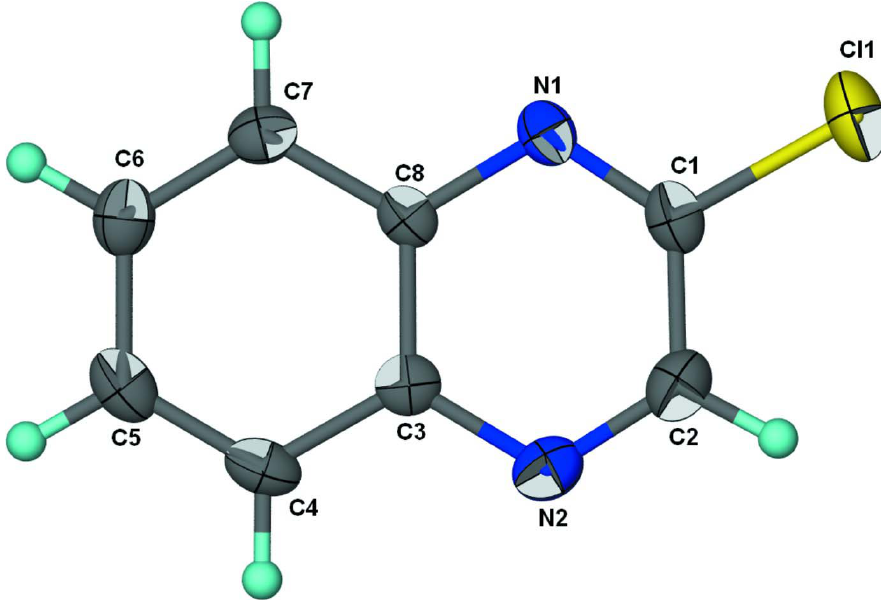
H ClN ; ellipsoids are drawn at the 70% probability level and H atoms of 8 5 2